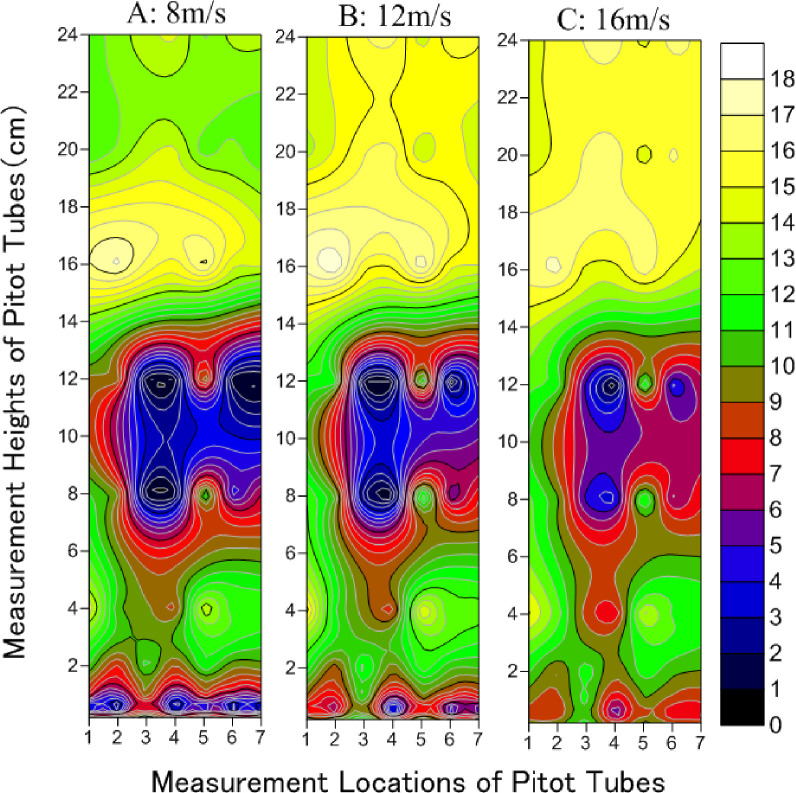
Distribution characteristics of airflow field in broom-shaped synthetic shrubs under wind speeds of 8, 12 and 16 m/s.(Numbers 1–7 of horizontal axis correspond to -8.75 (the windbreak front), 8.75, 26.25 (within the windbreak), 43.75, 52.5, 87.5 to 122.5 cm (downwind of windbreak), respectively).